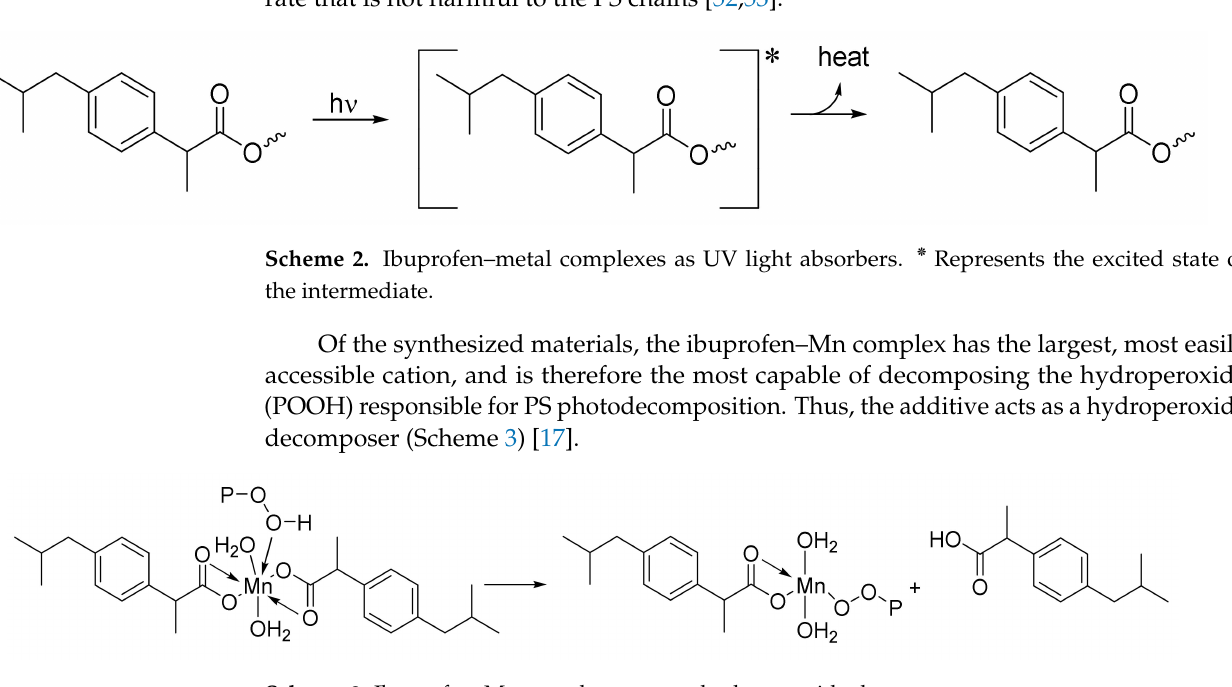
Table 3. Electronic spectral data, conductivity, magnetic moments, geometry, and hybridization of ibuprofen sodium salt and metal complexes obtained according to Scheme